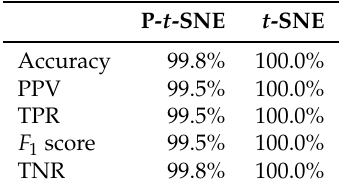
Table 8. Accuracy, PPV, TPR, F 1 score, and TNR of the application of P- t -SNE and t -SNE damage detection and classification method presented in Sections 3 and 4: scenario 2 and the sum of the inverse distances approach. P- t -SNE t -SNE 99.9%